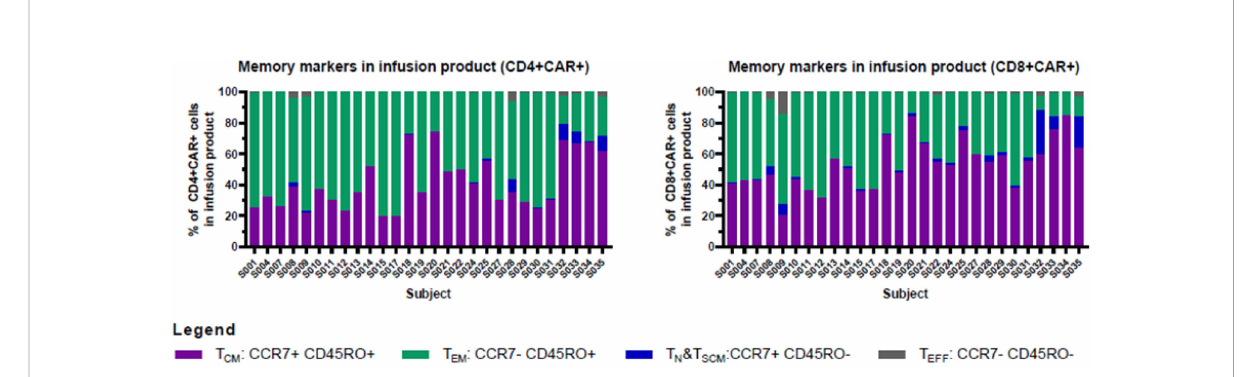
FIGURE 3 Memory markers in infusion product. CD4+ and CD8+ T cells in infusion products consisted mainly of cells with central memory or effector memory phenotypes. Cryopreserved cells were thawed, stained, and analyzed using an Aurora spectral cytometer as described in Materials and Methods. Graphs show the percentage of central memory (CCR7+ CD45RO+), effector memory (CCR7- CD45RO+), naïve/stem cell memory (CCR7+ CD45RO-), and effector (CCR7- CD45RO-) cells within the CAR+CD4+ (left), and CAR+CD8+ (right) T cell populations (gated on CD3+ CD45+ single viable cells).